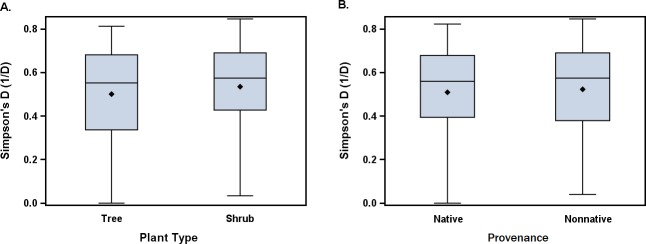
Comparison of bee genus diversity on trees and shrubs, and native and non–native plants.The bold line within the box indicates the median while the diamond indicates the mean. The lower whisker, lower box, upper box, and upper whisker indicate first, second, third, and fourth quartiles, respectively. Whiskers also show minimum and maximum values (range). Analysis of variance results are summarized in Table 4.